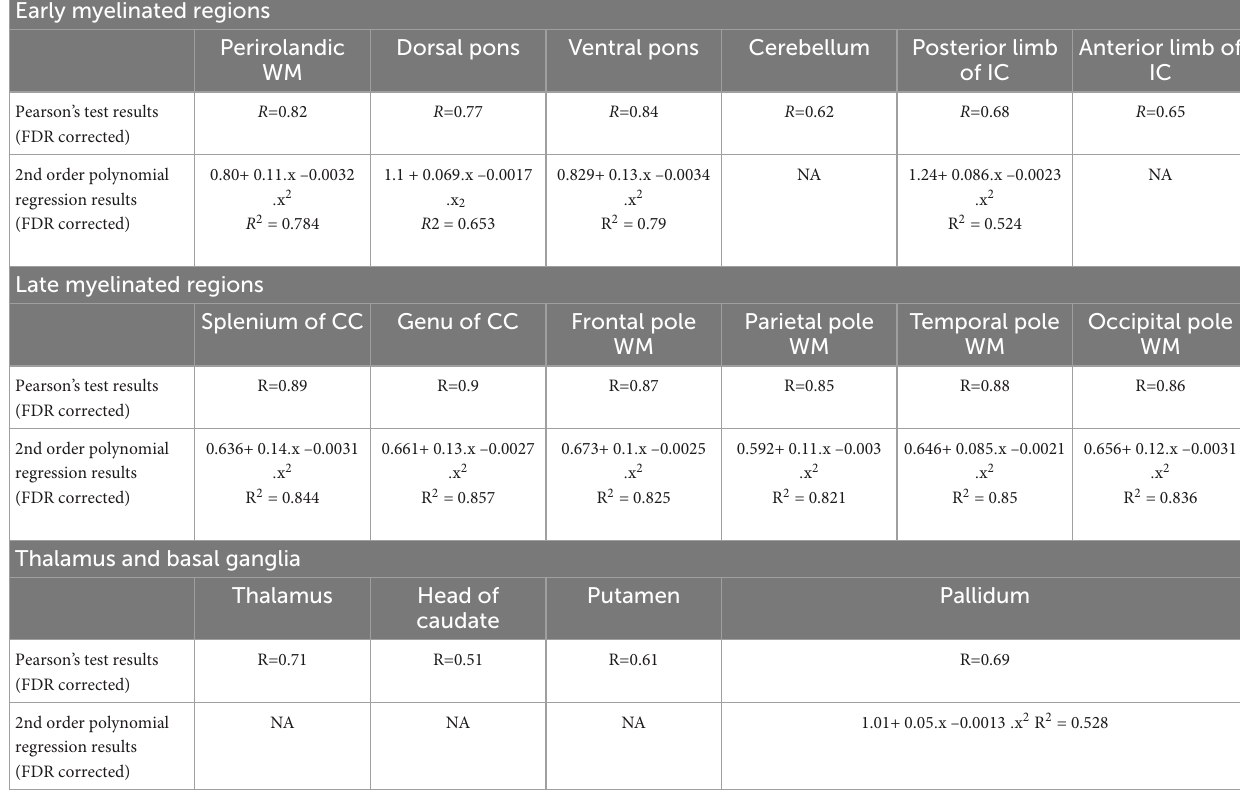
TABLE 1 Results of Pearson’s correlation analysis and 2nd order polynomial regression analysis between children’s age and the T1w/T2w ratio values. Early myelinated